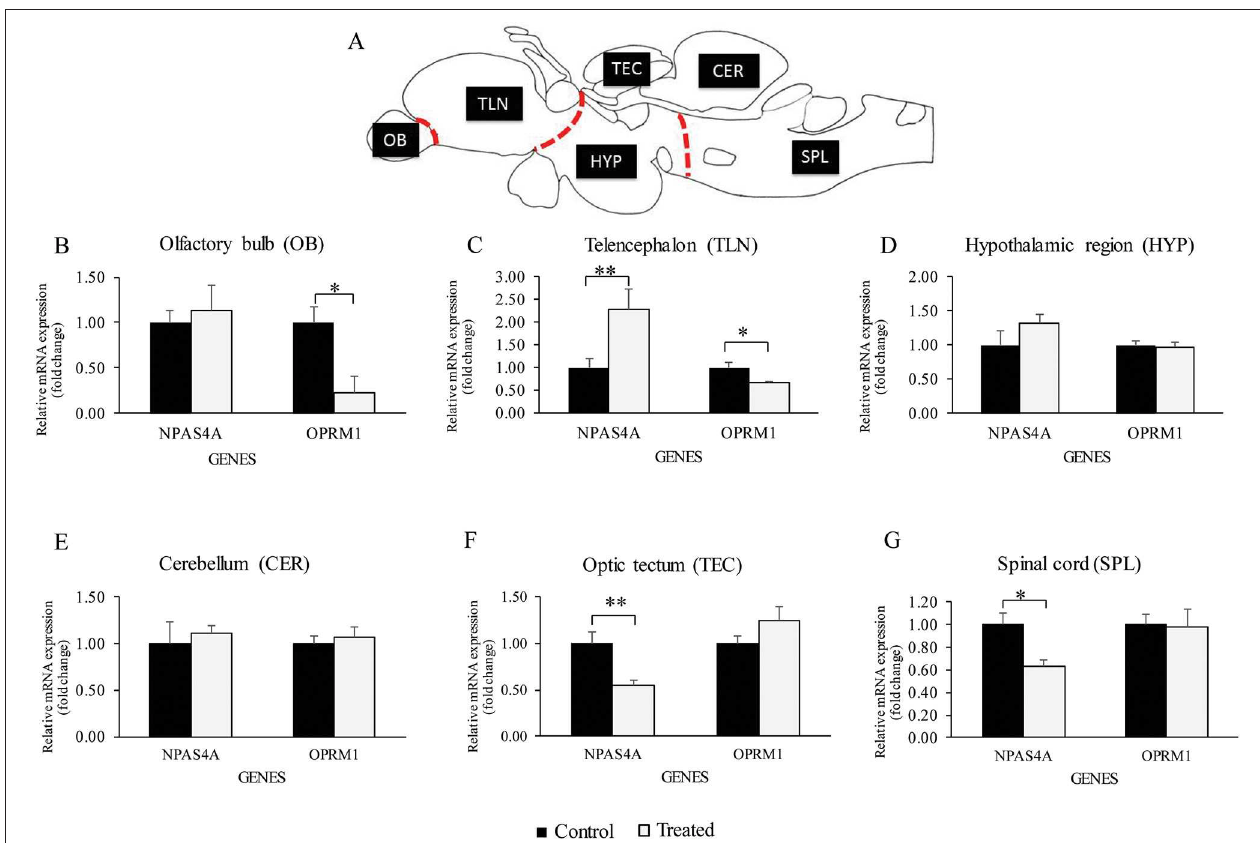
FIGURE 3 | Relative oprm1 and npas4a mRNA expression in the brain. (A–G) Graphs showing the relative gene expression (fold change) of oprm1 and npas4a mRNA expression after exposure to acute vehicle (Control) and morphine via water immersion (Treated) across several brain region. (A) Schematic sagittal drawing of macro-dissected brain region, (B) olfactory bulb region, (C) Telencephalon region, (D) Hypothalamic region, (E) Cerebellum, (F) Optic tectum, (G) Spinal cord region. Data are presented as mean ± SEM. Independent t -test comparisons between control and morphine-treated fish. * P < 0.05; ** P < 0.01 vs. controls ( n =